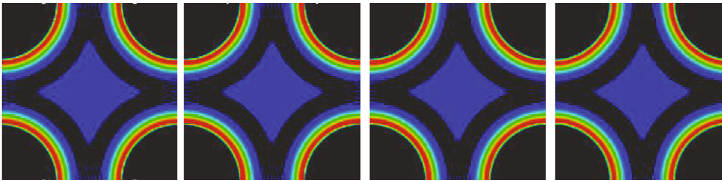
Figure 38: Contact stress cloud diagram of rock slab under di ff erent reservoir elastic moduli (25 GPa, 30 GPa, 35 GPa, and 40